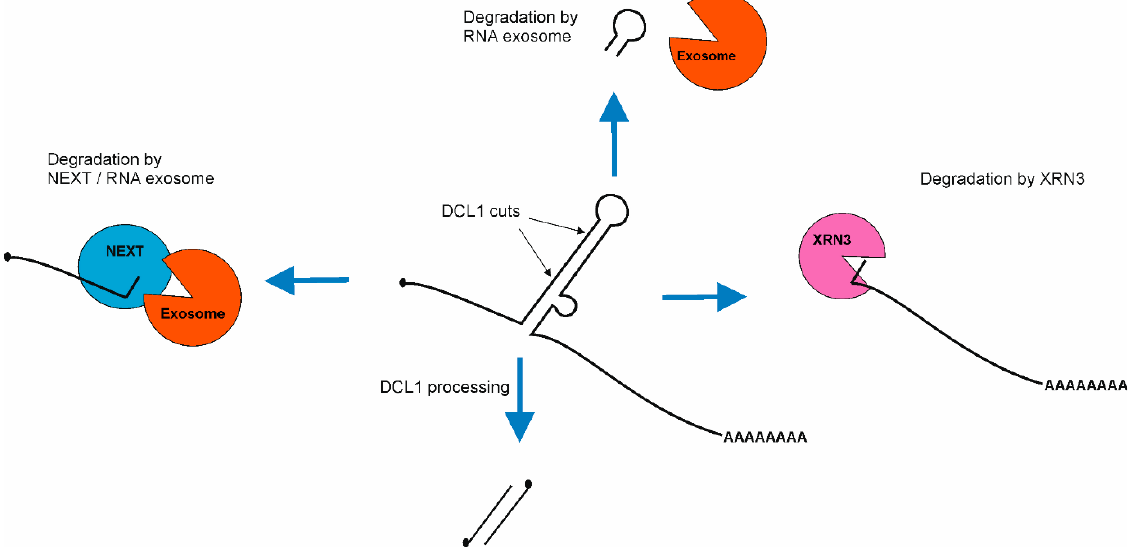
Figure 4. Scheme of pri-miRNA byproducts degradation after miRNA/miRNA* duplex excision. First, 5 ′ fragment of pri-miRNA is degraded using NEXT/RNA exosome machinery. Then, 3 ′ frag- ment of pri-miRNA is degraded using EXORIBONUCLEASE3 (XRN3). The apical fragment of stem–loop is degraded suing nuclear RNA exosome.